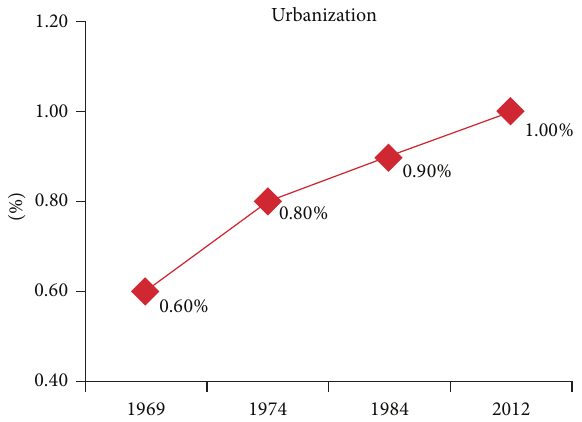
Figure 7: Urbanization in the period from 1969 to 2012 for urban area of the Prokuplje Municipality: derived from topographic maps (TK 1: 25,000, section 582 Nis: 1-4, 3-2, 1-3, 3-1, 3-3, and 3-4, 581 Kursumlija: 4-1, 2-4, 4-2, and 4-4) and also from Land Cover Map obtained by using CORINE-like approach in